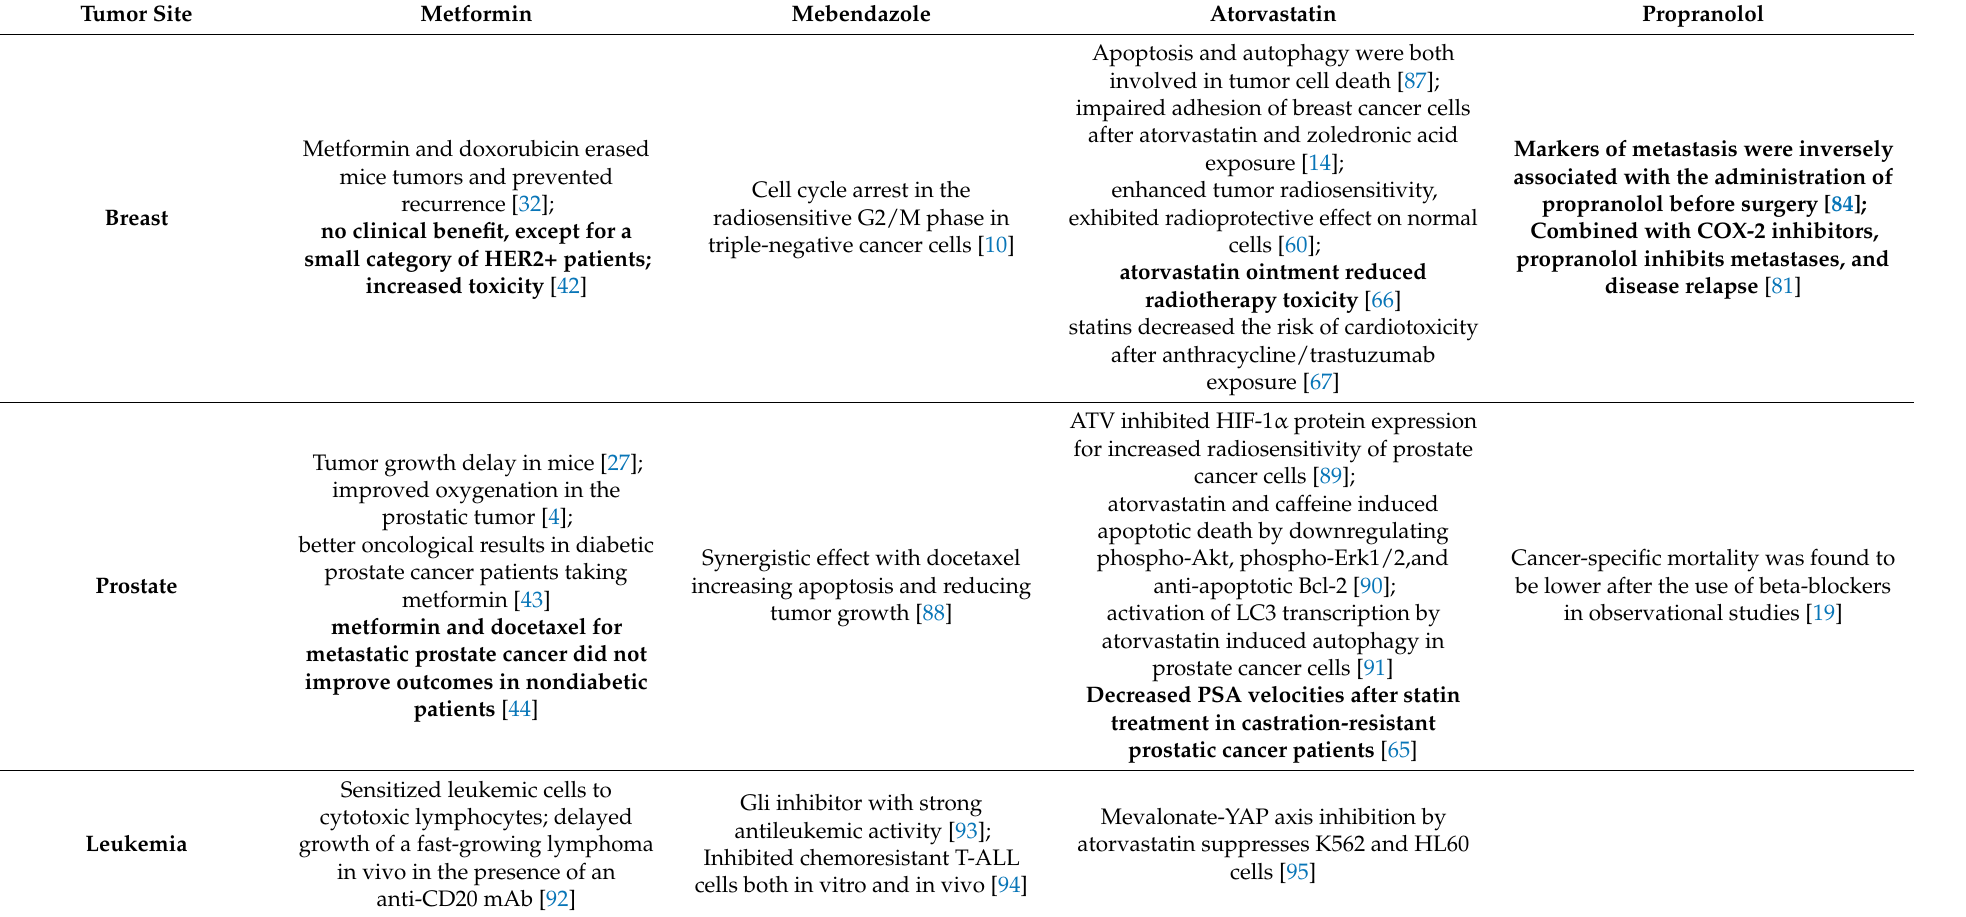
Table 1. Main in vitro, in vivo, and clinical results in oncology for metformin, mebendazole, atorvastatin, and propranolol. Clinical prospective studies are in